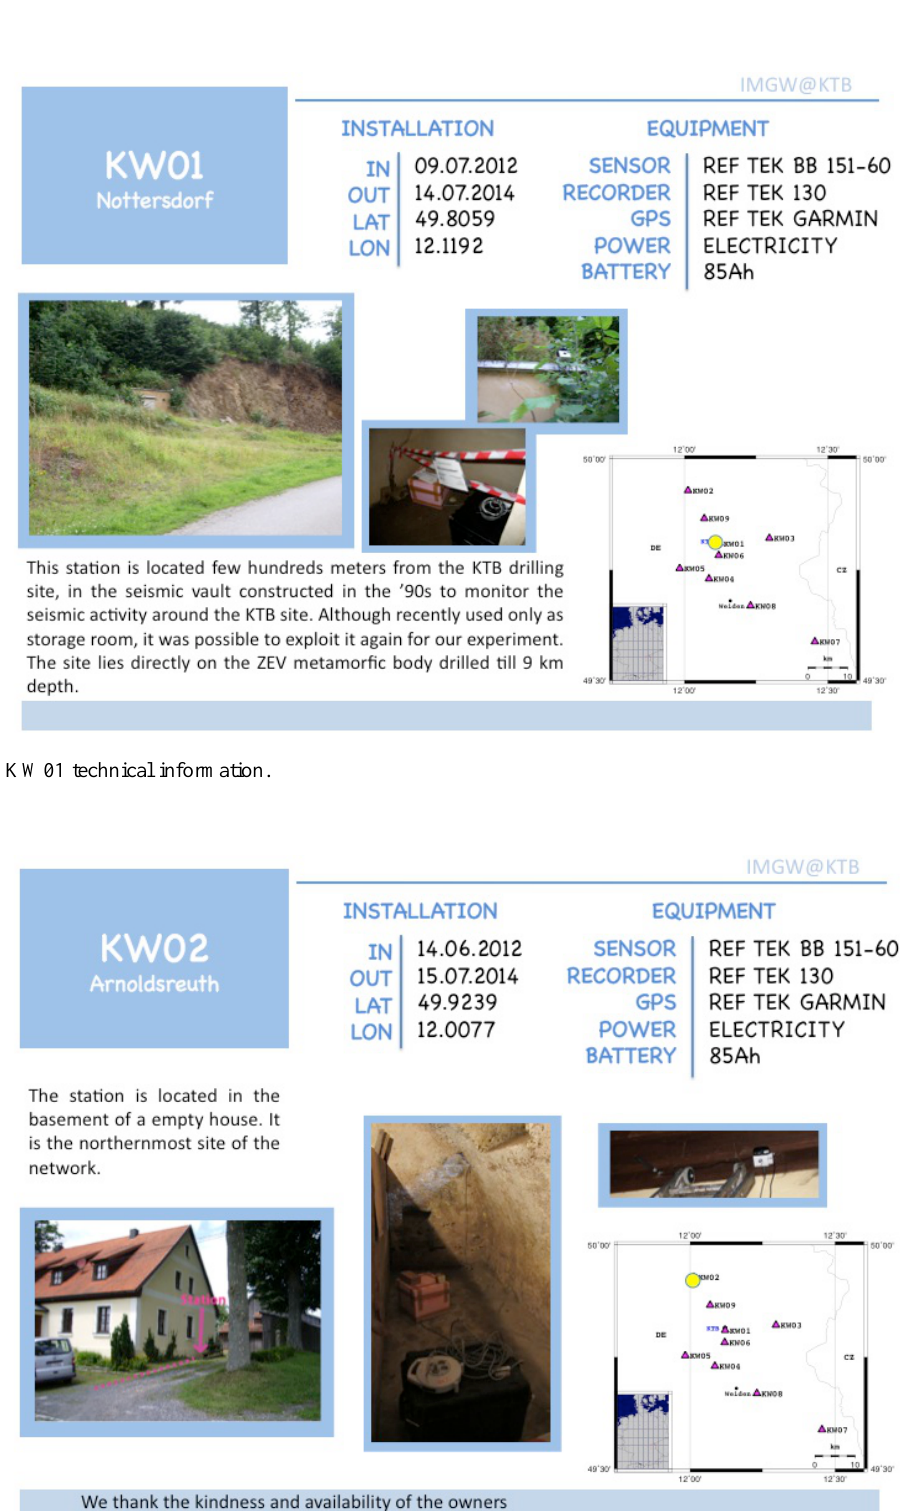
Figure A2. Station KW02 technical